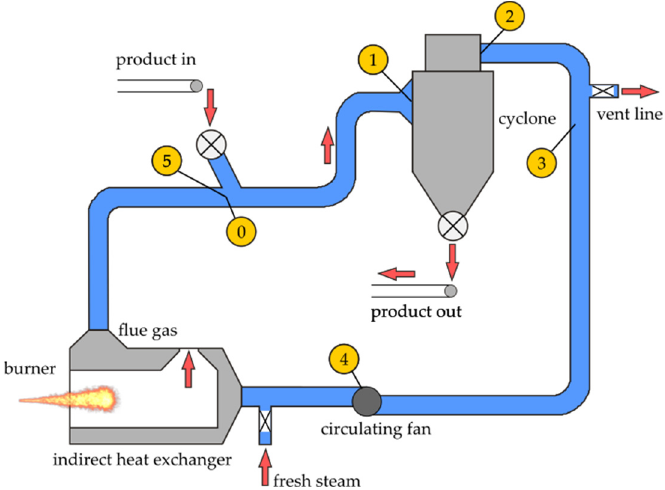
Figure 10. Schematic of a superheated steam flash dryer.